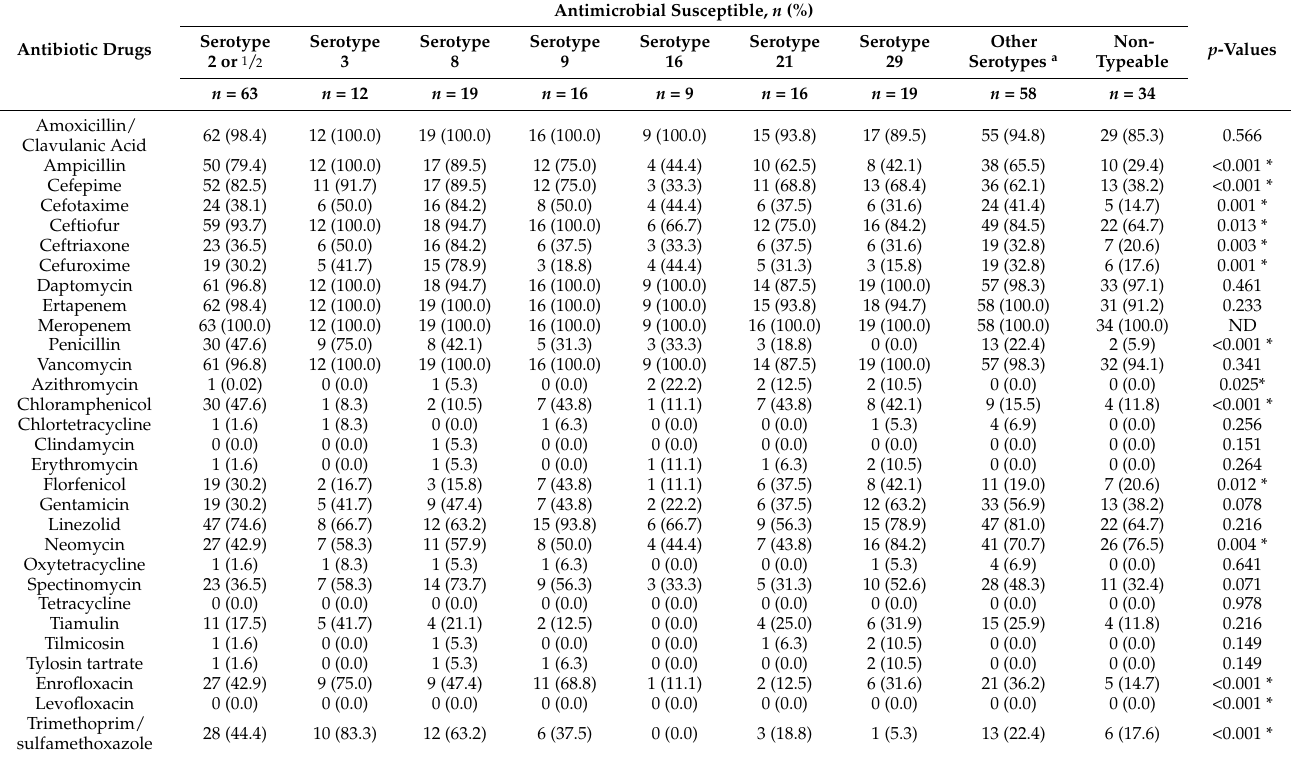
Table 4. Antimicrobial susceptibility of S. suis strains according to